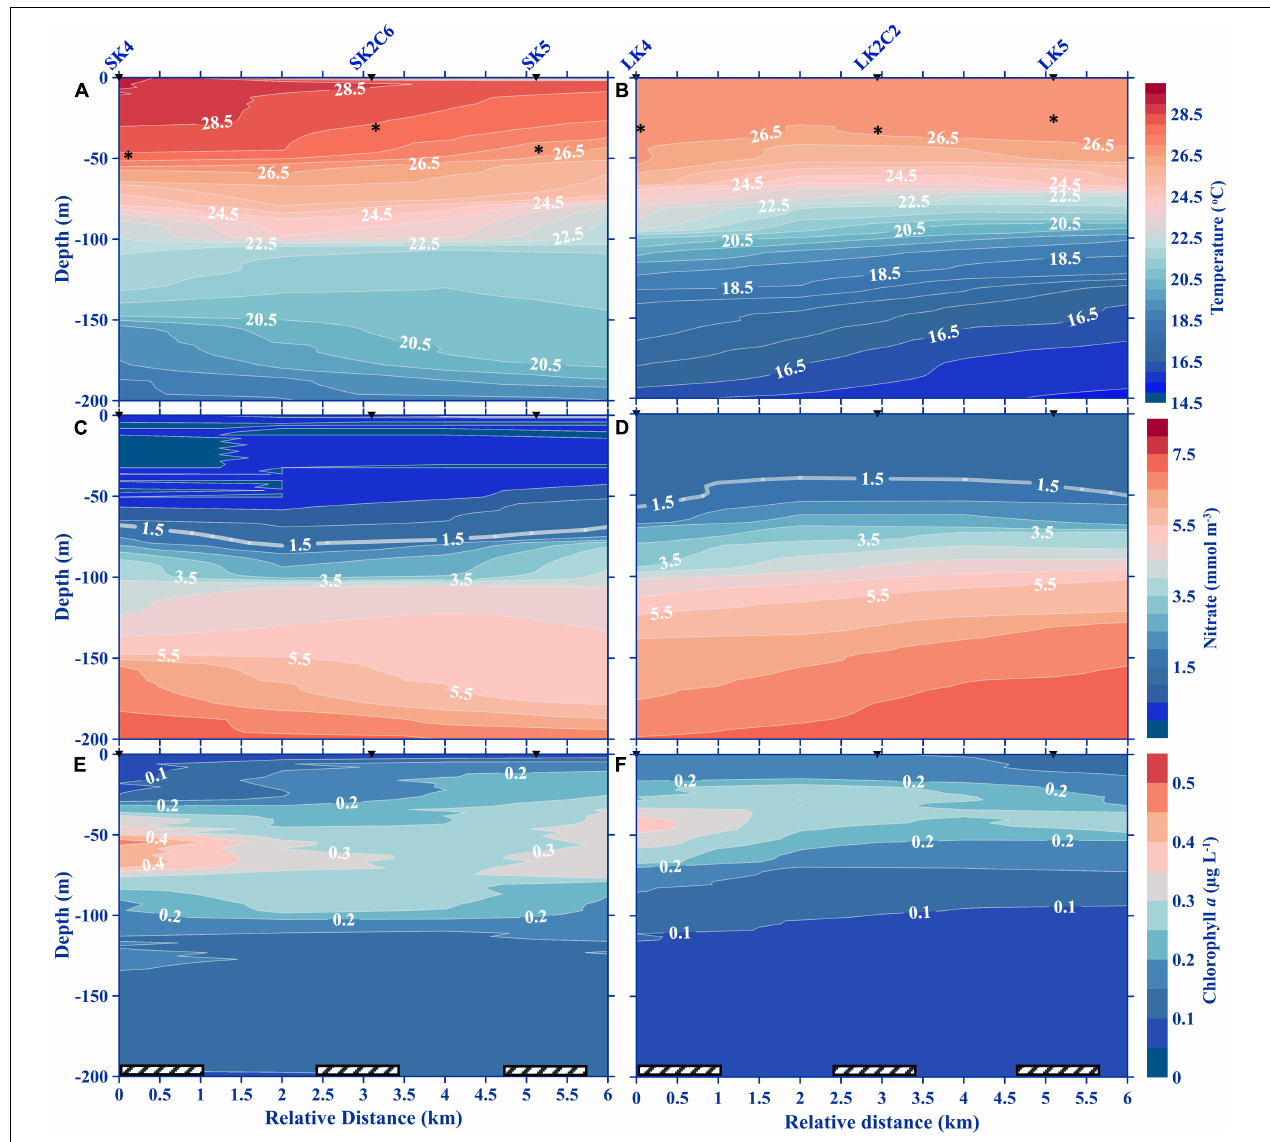
FIGURE 5 | Vertical profiles of temperature (A,B) , nitrate (C,D) , and Chl a (E,F) in the cross-stream transect during small (2016) and large (2018) billow conditions. The cast and station numbers denoted above the top graph apply to all panels in the column. Asterisks on the temperature panels denote the mixed layer depths. Hatched bars along the x -axis indicate nighttime